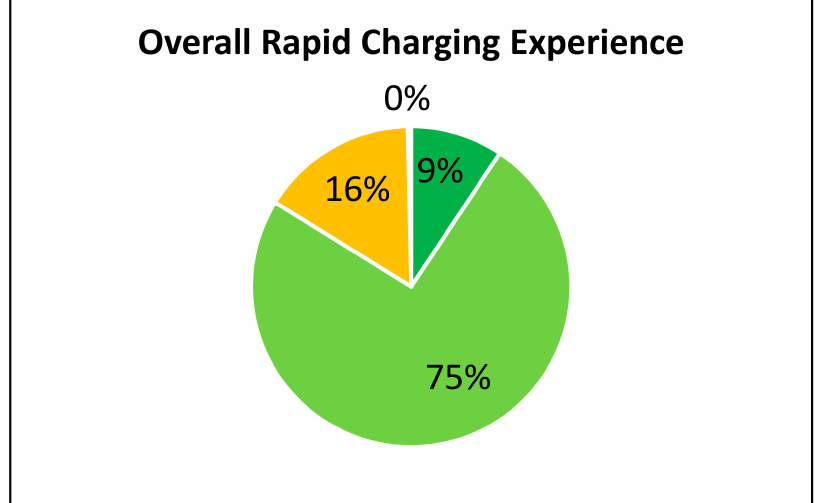
Figure 26. Users’ overall rapid charging